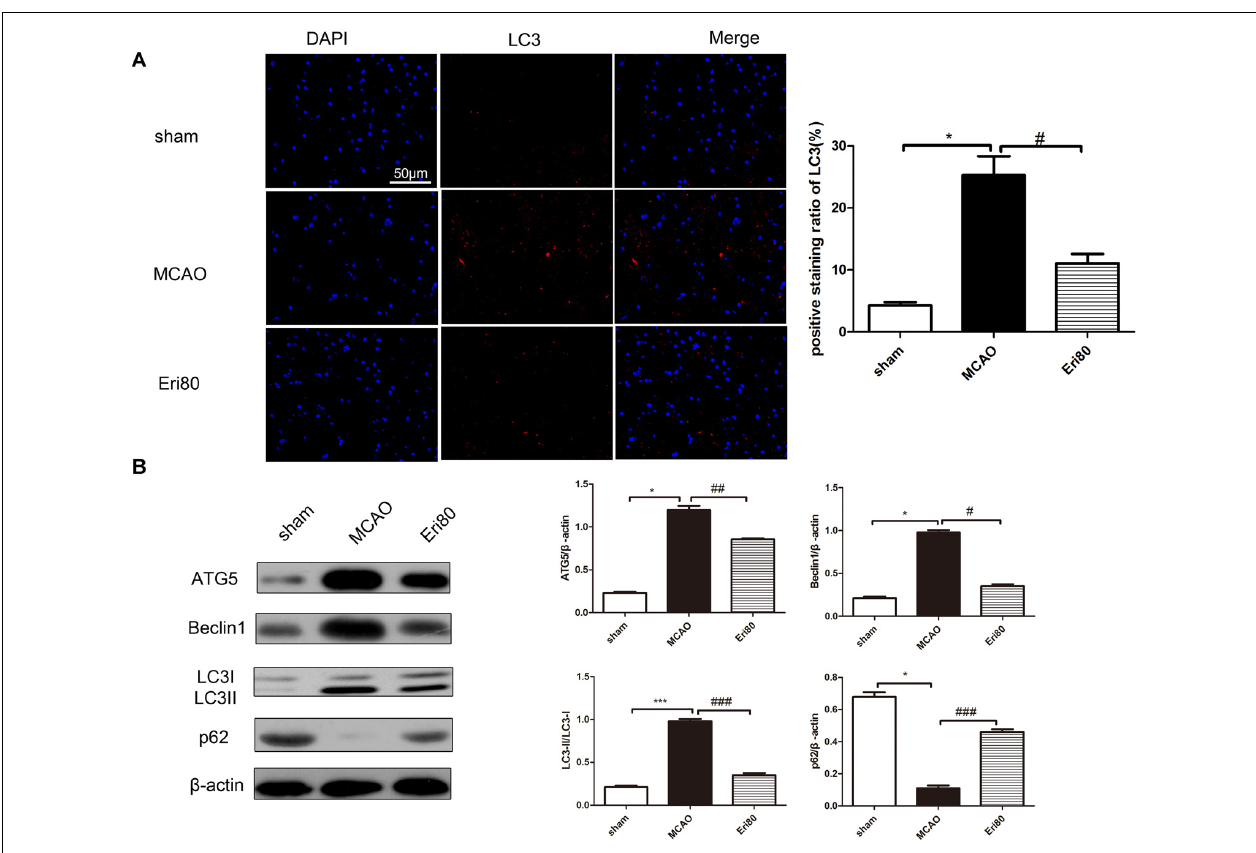
FIGURE 5 | Eriodictyol suppressed the MCAO-induced autophagy. Autophagy activity was assessed by determining the ratio of LC3II/LC3I, the expression of ATG5, p62, and Beclin1 via western blotting assay and analyzed by Image J software. (A) The protein expression of LC3 was detected by immunofluorescence staining. The LC3-positive signal was shown in red and DAPI was shown in blue. Scale bar: 50 µ m (vs. sham group, * P < 0.05, vs. MCAO group, # P < 0.05, n = 3). (B) The expressions of ATG5, Beclin1, p62, and LC3II/LC3I were assessed via western blotting assay and analyzed using ImageJ software. Compared with the sham group, the expressions of ATG5, Beclin1, and LC3II/LC3I in the MCAO group were upregulated significantly, while, the expression of p62 was downregulated. After treatment, the protein expressions were reversed (* P < 0.05, *** P < 0.001, vs. sham group; # P < 0.05, ## P < 0.01, ### P < 0.001, vs. MCAO group, n =